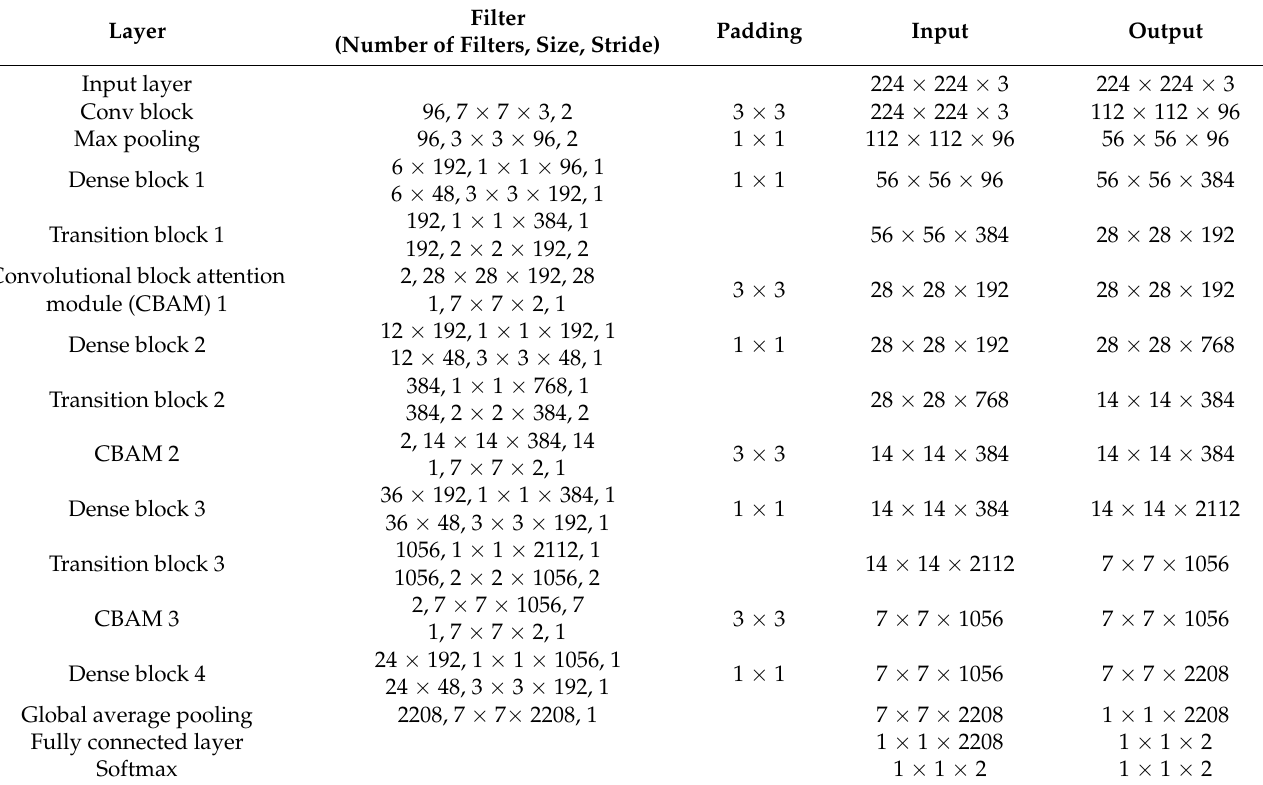
Table A2. Structure of attention-guided DenseNet.